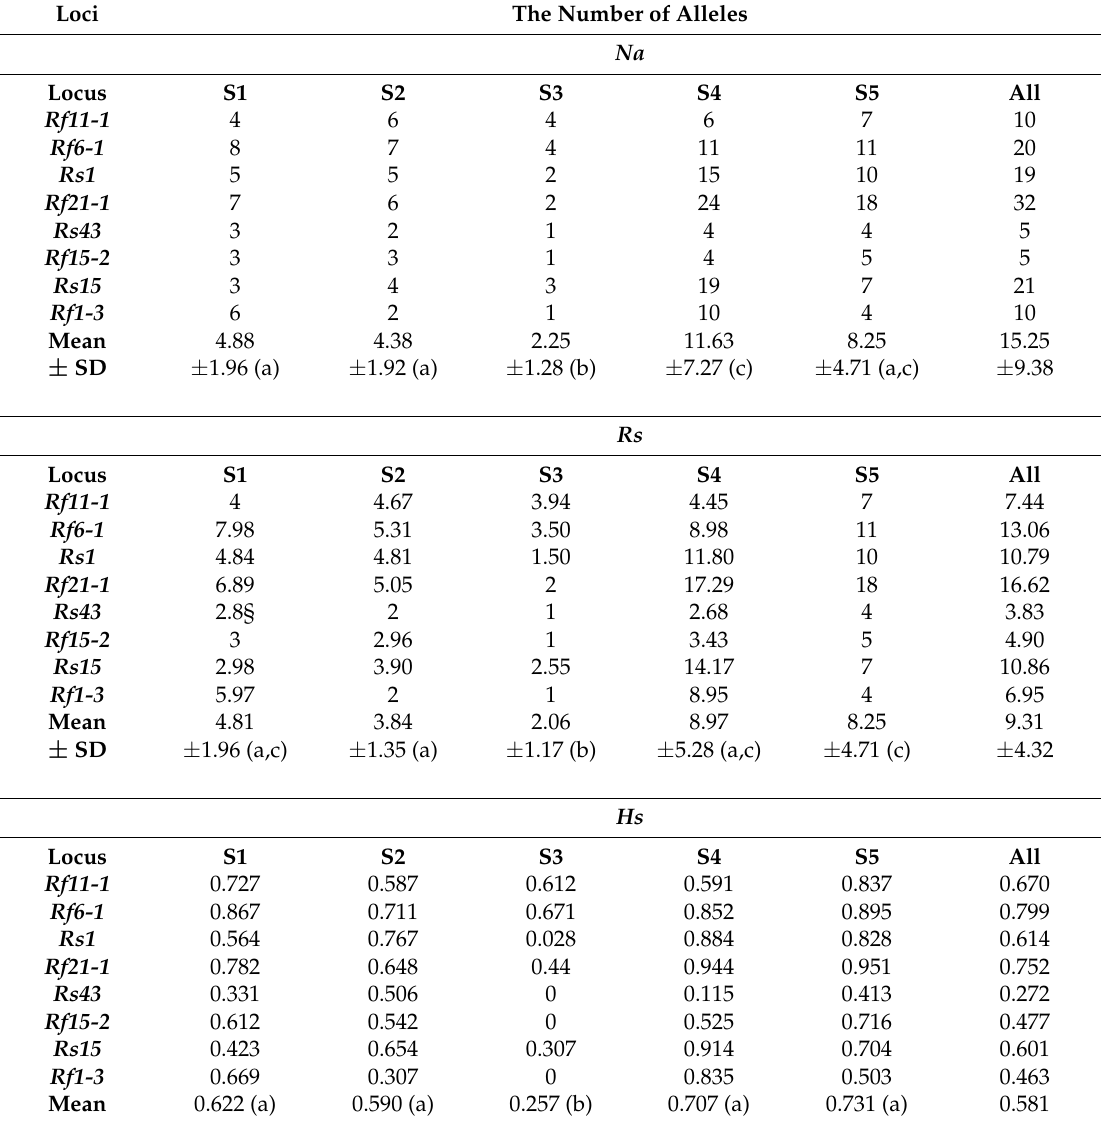
Table 1. Genetic diversity of the five Reticulitermes flavipes clusters (S1 to S5) identified by S TRUCTURE using eight microsatellite loci (n = 164 workers). The number of alleles per locus ( Na ), allelic richness ( Rs ), and gene diversity ( Hs ) were calculated. Loci The Number of Alleles